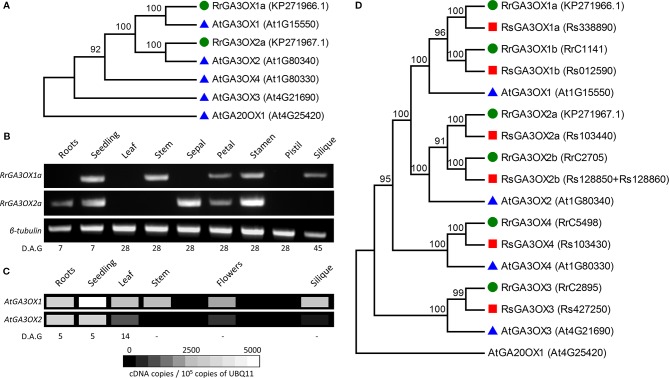
Characterization of wild radish GA3OX genes. (A) Phylogenetic relationship between the protein sequence of the two cloned wild radish GA3OX genes (RrGA3OX1a and RrGA3OX2a; green circles) and those of Arabidopsis (blue triangles). AtGA20OX1 represents an out-group. GenBank (Rr) and TAIR (At) gene/protein identifiers are in parentheses adjacent to gene names. (B) Semi-quantitative real time (RT)-PCR showing RrGA3OX1a and RrGA3OX2a expression in a range of wild radish tissues. For primer specificity, see Supplementary Figure S5. (C) Virtual gel heat map showing quantitative expression levels of AtGA3OX1 and AtGA3OX2 in different Arabidopsis tissues. Data adapted from quantitative PCR (qPCR) analysis published in Mitchum et al., 2006. (D) Phylogenetic relationship between Arabidopsis (AtGA3OX; blue triangles), wild radish (Raphanus raphanistrum; RrGA3OX; green circles), and cultivated radish (Raphanus sativus; RsGA3OX; red squares) GA3OX protein sequences. The genomes of both wild radish and R. sativus carry six GA3OX genes consisting of two ohnologs for both GA3OX1 and GA3OX2, in addition to single copies of GA3OX3 and GA3OX4 paralogs. GenBank (RrGA3OX1a and RrGA3OX2a), RadishDB (other Rr), RadishGB (Rs), and TAIR (At) gene/protein identifiers are in parentheses adjacent to gene names.